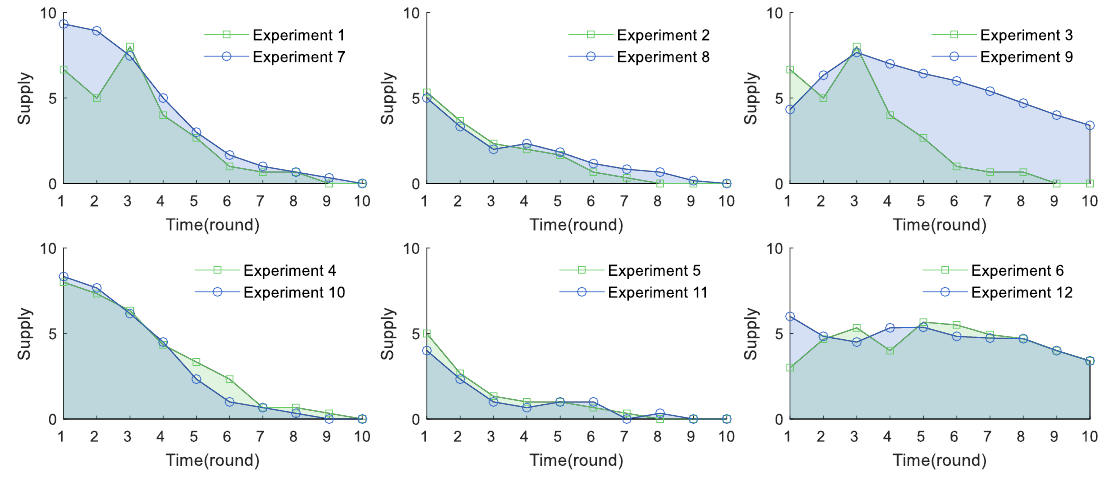
Figure 3. Effects of communication on supply.